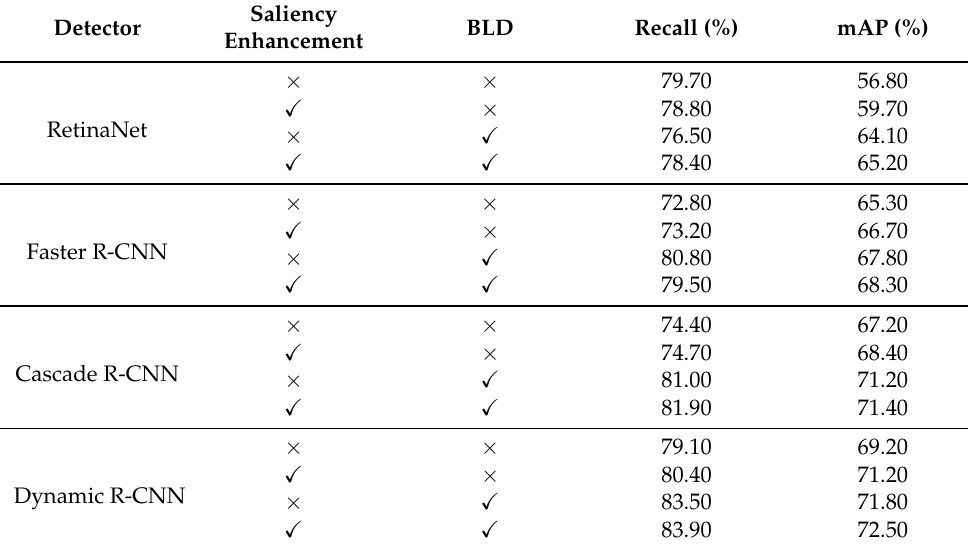
Table 3. Ablation experiments on different